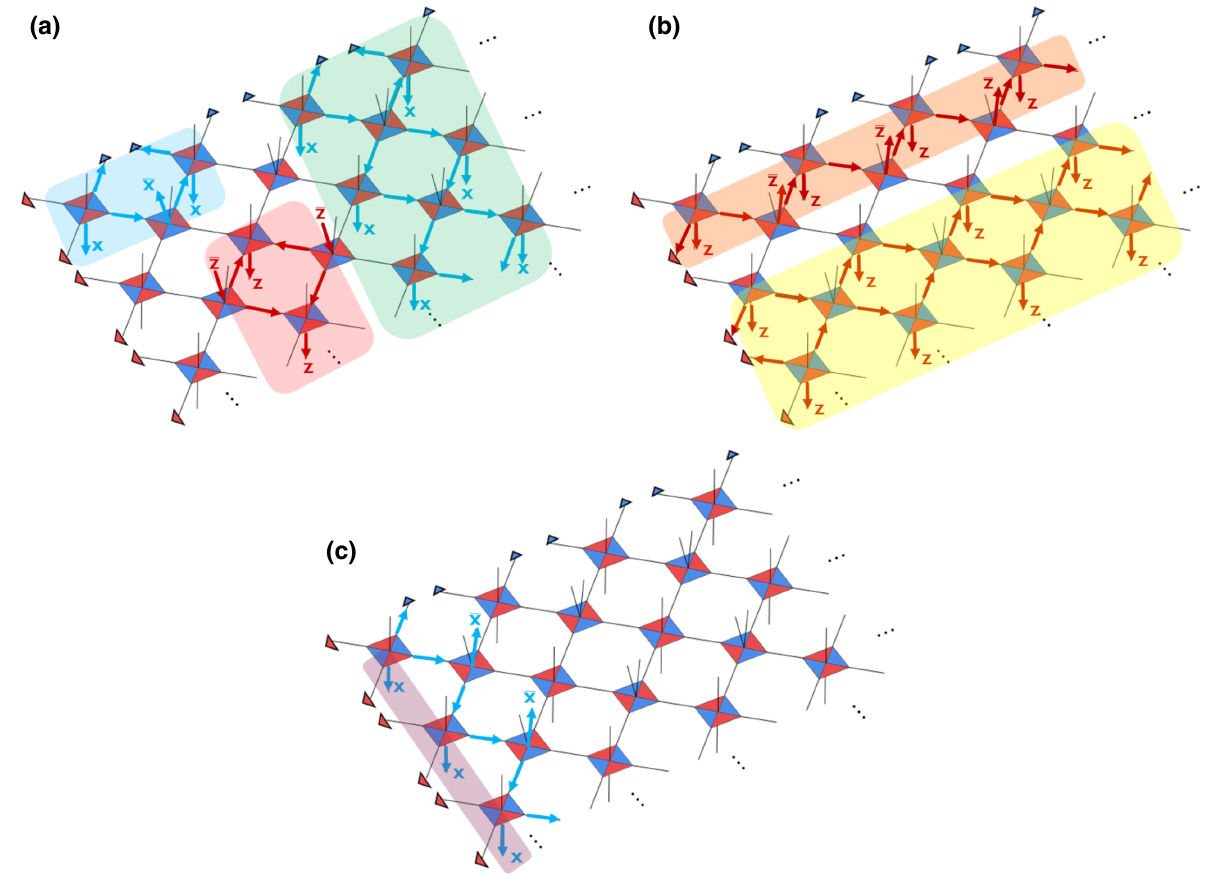
FIG. 22. The tensor network of a 2D Bacon-Shor code. (a) shows the operator pushing that leads to the X - (blue) and Z - (red) type gauge operators by pushing logical and stabilizer operators. If we push only stabilizers of the local tensors, this results in a stabilizer generator ( X type, green) and ( Z type, yellow) in (b). (b) and (c) show the operator pushing that correspond to the logical operator that has high weight. These X - and Z -type logical operators, shaded in purple and orange, respectively, act on a column or a row.